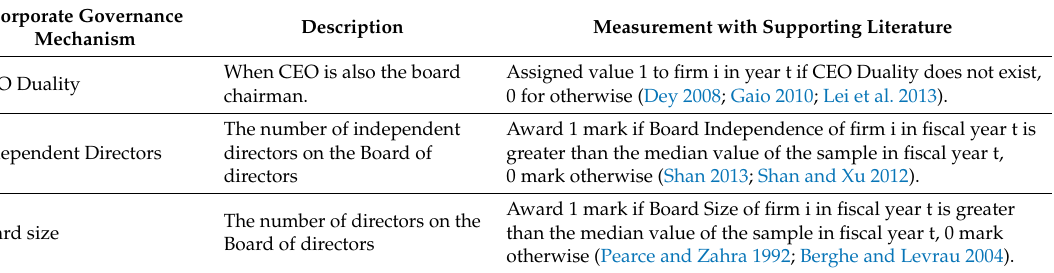
Table 1. Constructing the Corporate Governance